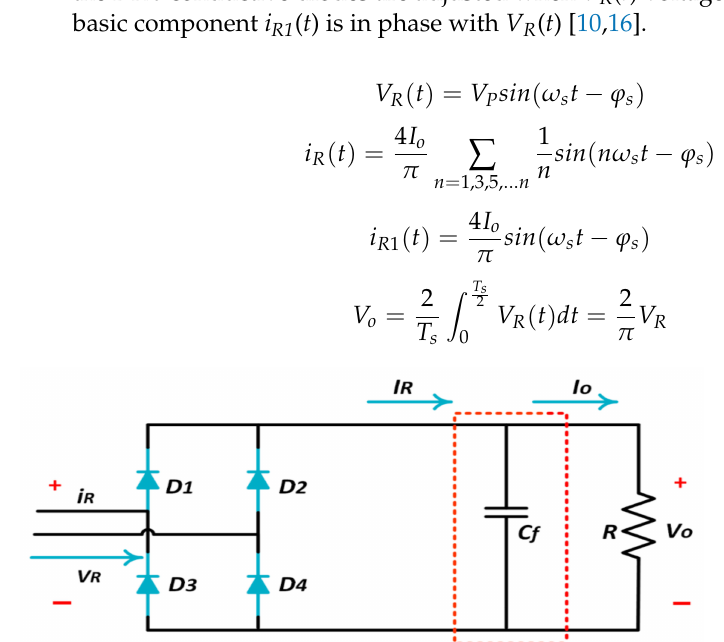
Figure 21. Diode rectifier with capacitive output filter [10].